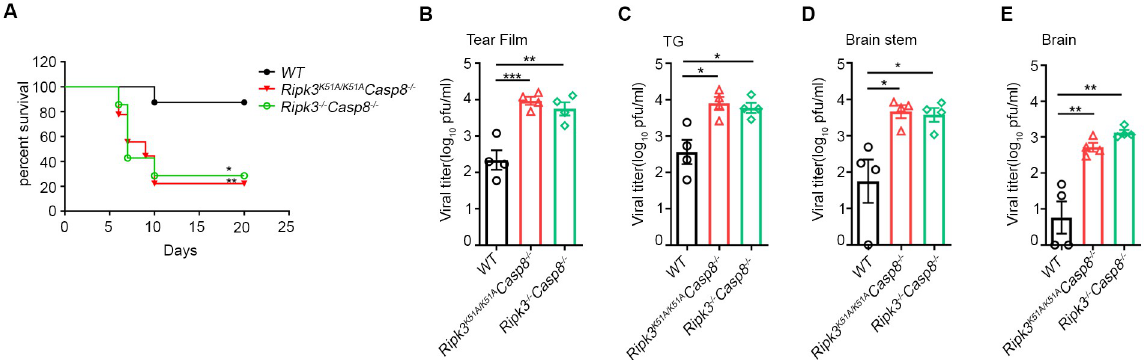
Fig 2. Caspase 8 contributes to RIPK3 protection within CNS against HSV1. Mice were infected as above described. (A) Plot showing percent survival of WT (n = 8), Ripk3 -/- Casp8 -/- (n = 9) and Ripk3 K51A/K51A Casp8 -/- (n = 7) mice after HSV1 infection. Viral titers at 5 dpi in (B) tear film, (C) trigeminal ganglion (TG), (D) brainstem, and (E) combined cerebrum and cerebellum tissues were tested (n = 4–5 per group). Values are expressed as means ± SEM ( � P < 0.05, �� P < 0.01, ��� P <